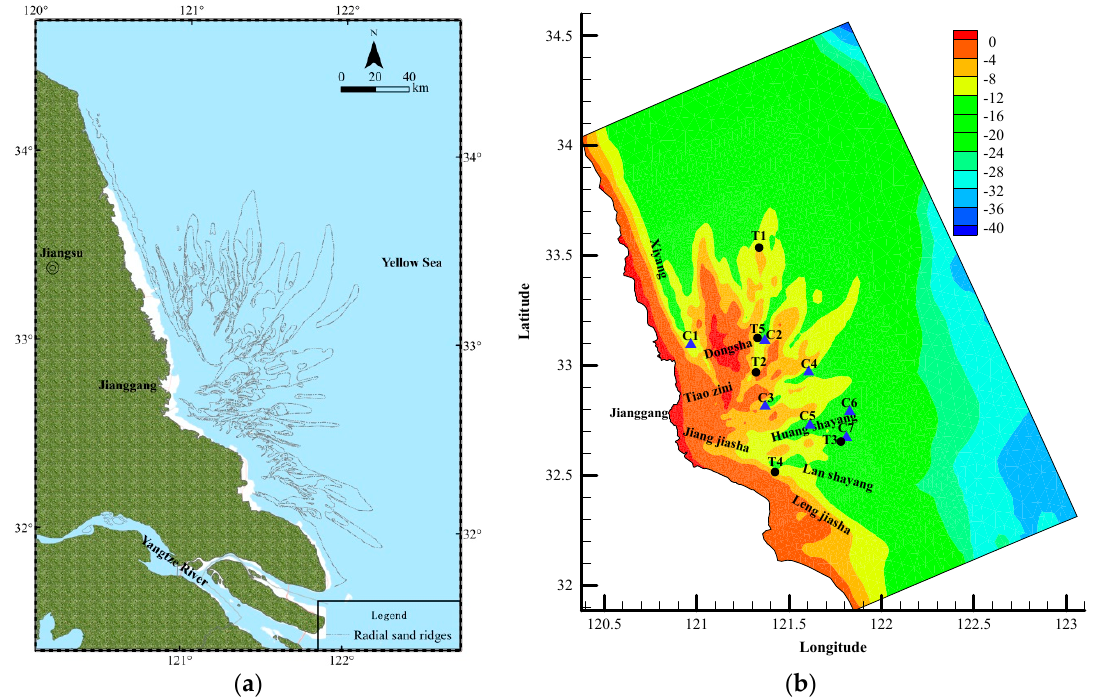
Figure 1. ( a ) The area of the coastal waters of Jiangsu; ( b ) The bathymetry and observation points ( ● signify the tide level observation points; ▲ signify the tidal current observation points).